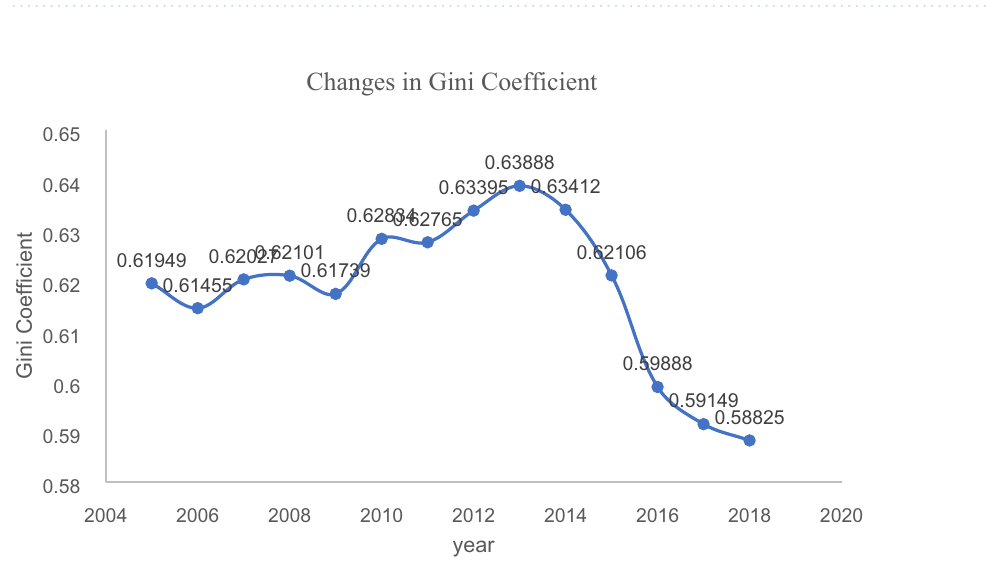
Figure 6. Study on the changing track of the population gravity center in BTHUA. It mainly shows the specific location of the population gravity center at BTHUA.